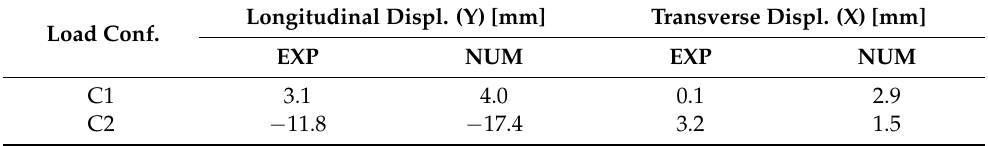
Table 4. Comparison between the experimental and numerical displacements of the isolator (I). Load Conf.